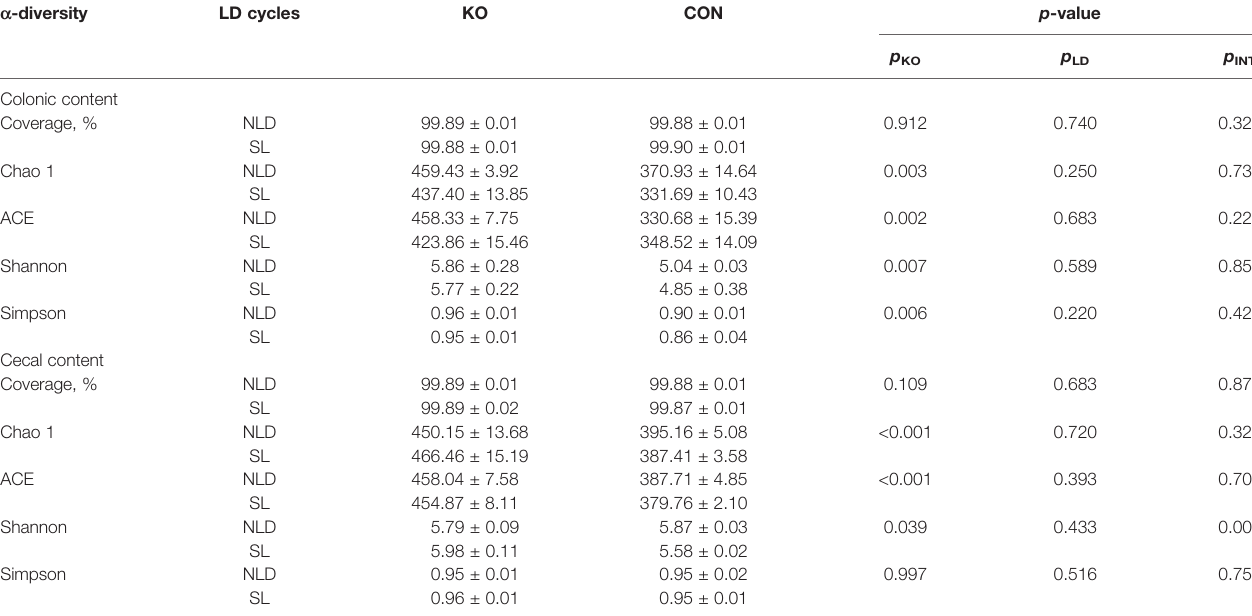
TABLE 3 | Sequencing coverage and a -diversity indicators of gut microbiome. a